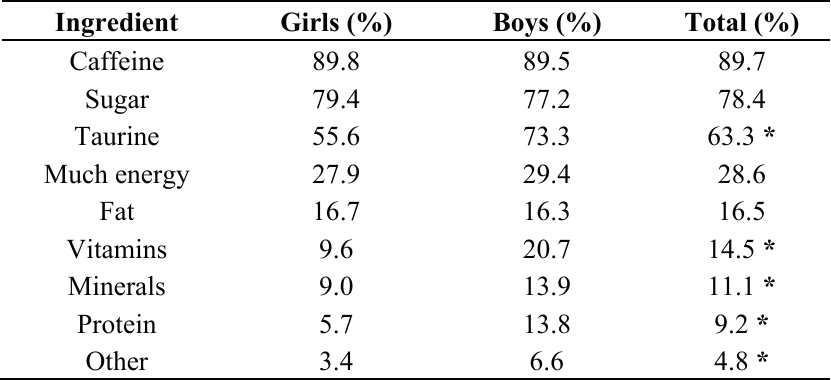
Table 3. Knowledge of the ingredients of energy